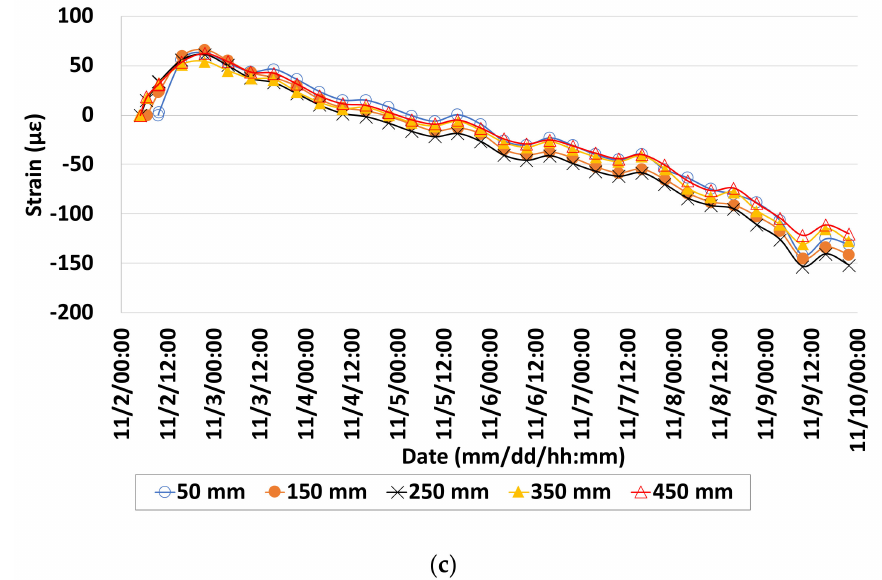
Figure 12. Real strain according to the slab depth for the first seven days: ( a ) corner, ( b ) mid-edge, and ( c ) center.